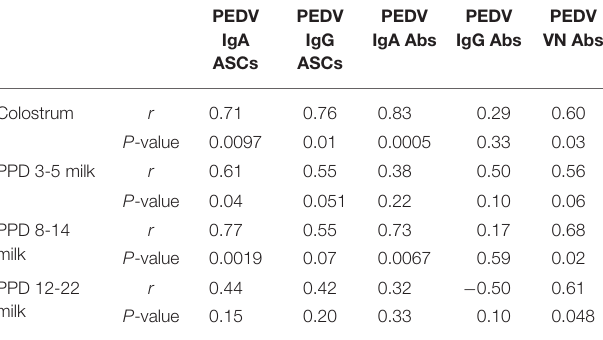
TABLE 2 | Spearman’s non-parametric correlations between piglet survival rate and numbers of PEDV IgA and IgG antibody secreting cells (ASCs) and log 10 -transformed PEDV IgA, IgG, and virus neutralizing (VN) antibody (Ab) titers in colostrum, postpartum day (PPD) 3–5 milk, PPD 8–14 milk, and PPD 15–22 milk in first, second, and third trimester PEDV-infected